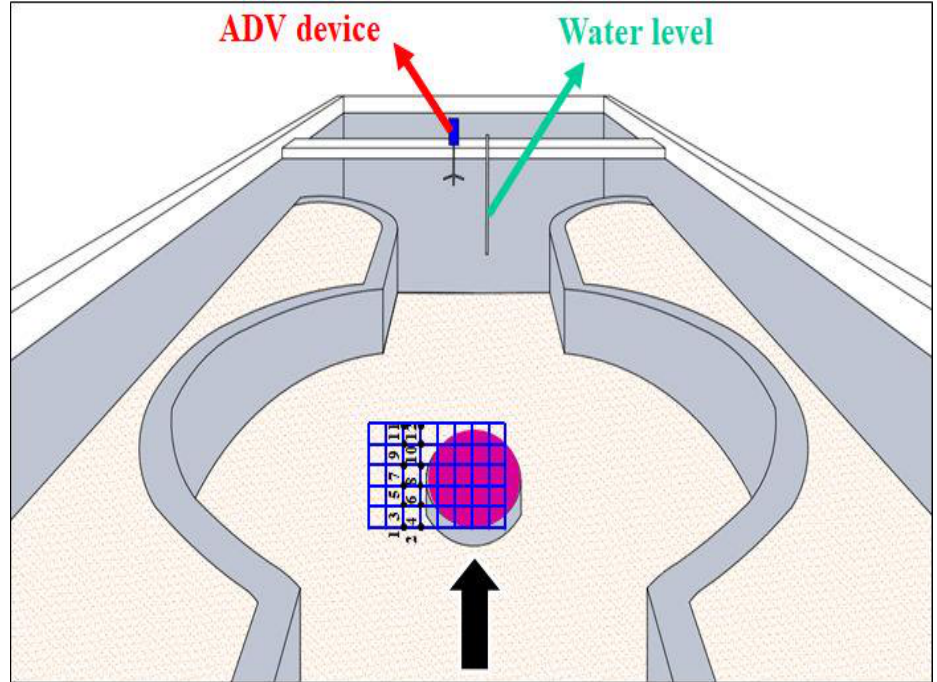
Figure 1. Overview of the laboratory flume employed in the present experimental study, with detailed views of the ADV device, the emerging bar (purple ellipse), and the measuring grid (in blue) composed of 10 cm × 10 cm cells. The black arrow denotes the flow direction. The measuring points analyzed are indicated listed from 1 to 12.